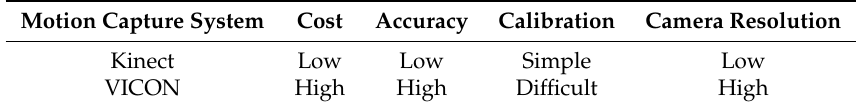
Table 2. Summary of VICON and Kinect II